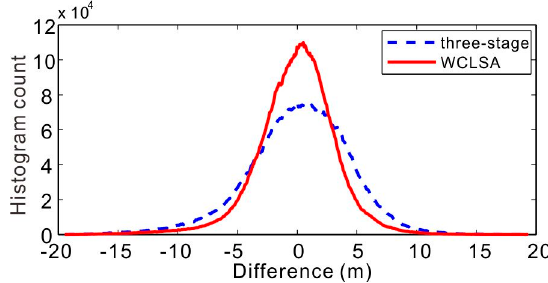
Figure 7. Differences of FUDEMs derived by three-stage and WCLSA with respect to the LiDAR DEM.